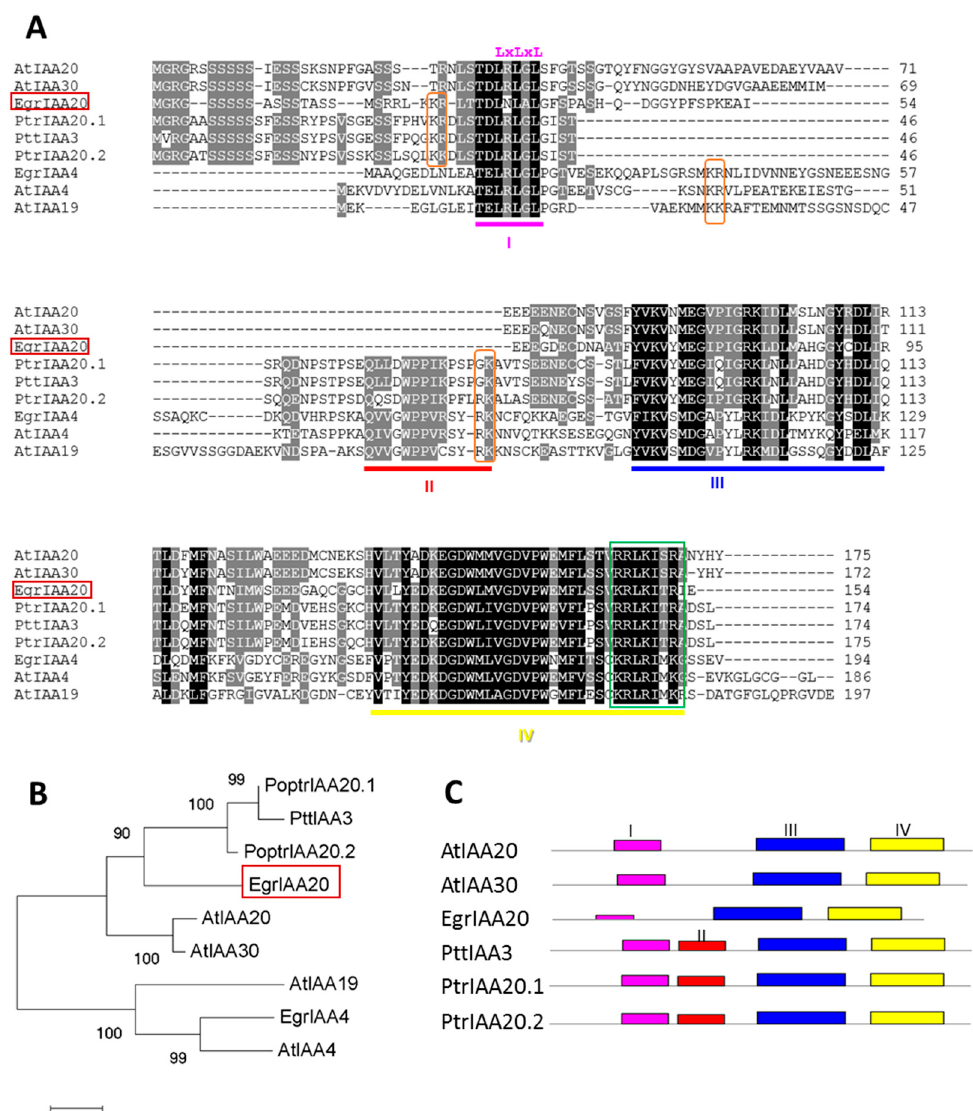
Figure 2. EgrIAA20 defines a non-canonical Aux/IAA protein which lacks highly conserved Aux/IAA characteristic Domain II. ( A ) Sequence Analysis of EgrIAA20 . Sequence comparison of EgrIAA20 , putative orthologs from other plants, and paralog of Aux/IAA protein family. Conserved residues are shaded in black; gray shading indicates similar residues in at least 5 out of 9 of the sequences. Four conserved domains I, II, III, IV are underlined. Conserved basic residues that putatively function as NLS are indicated by orange frames (Type I) and green frame (Type II). The core repression EAR motif in Domain I is indicated by “LxLxL” on the top of the alignment. ( B ) The phylogenetic relationship of EgrIAA20 with its related putative orthologs from Arabidopsis and poplar defines a distinct clade with Arabidopsis AtIAA20 and AtIAA30, and previously characterized wood-related aspen member PttIAA3. ( C ) Shema of proteins structures for EgrIAA20 and its closely related putative orthologs from poplar and Arabidopsis. The domains of Aux/IAA proteins were predicted by Pfam (http://pfam.xfam.org, accessed on 23 April 2020) and are indicated by different colors; Domain II (red box) was absent for EgrIAA20 , AtIAA20, and AtIAA30, but present in PtrIAA20.1, PtrIAA20.2, and PttIAA3.